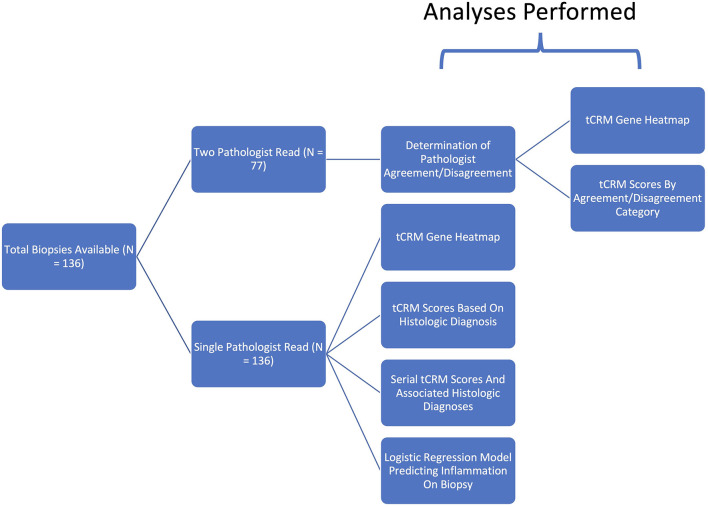
Schematic of study design and analyses performed.